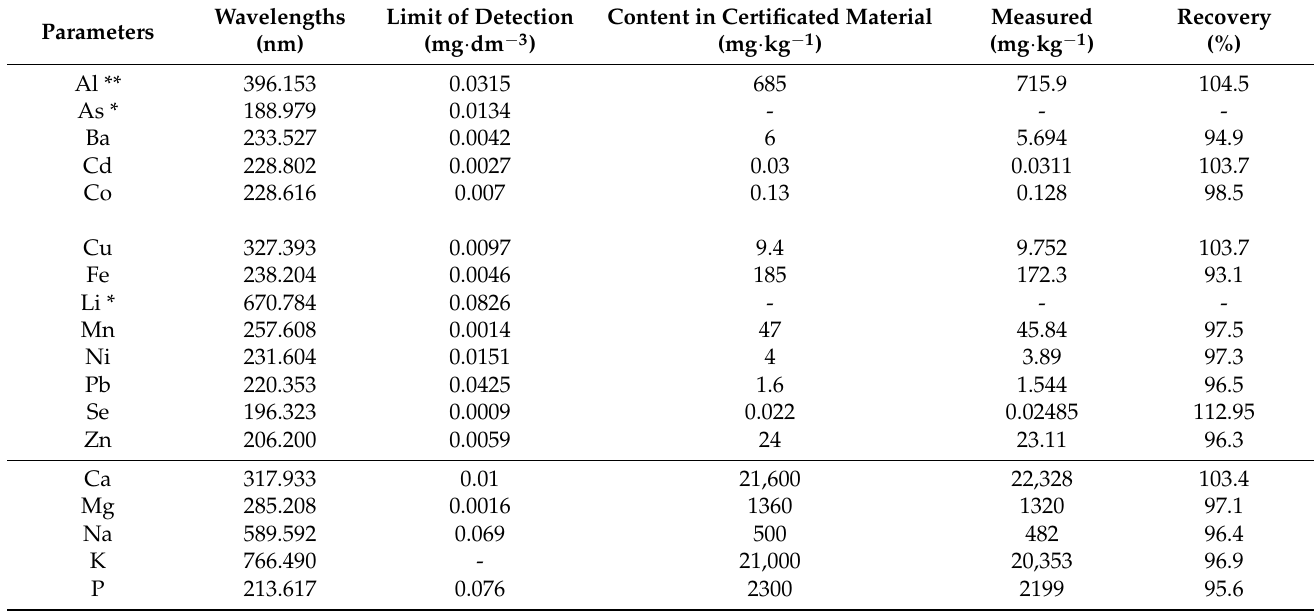
Table 8. Parameters of the analysis